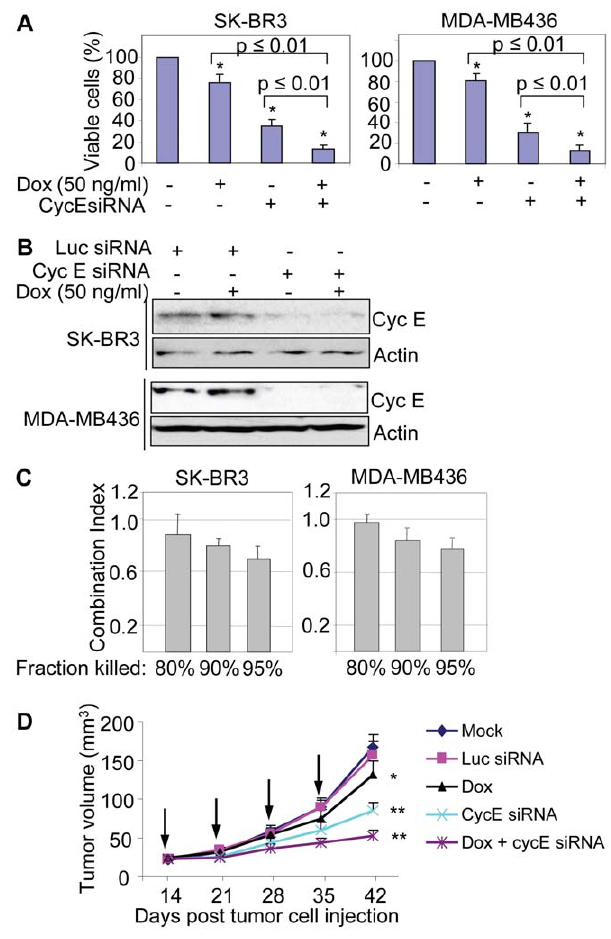
Figure 5. Enhanced inhibitory effects by combination of cyc E siRNA with Dox. A ) Sensitization of breast cancer cells to Dox by treatment of cyc E siRNA. Indicated breast cancer cells (1 6 10 5 /well in 6- well plates) were transfected with cyc E siRNA (0.1 m g/well) for 24 hours. The cells were then split into 96-well plates (2 6 10 3 cells/well) and treated with Dox (50 ng/ml) for 8 days.MTT assay was performed todeterminecell viability. Y-axis represented the relative MTT value from each treatment. (*) p # 0.05 compared with mock. B ) CycE levels are not affected by Dox. CycE-overexpressing breast cancer cells (SK-BR3 and MDA-MB436) were treated without or with siRNA alone, Dox (50 ng/ml) alone or in combination for 48 h. Treated cells were collected and the lysates were subjectedtoWesternblot analysis withanti-cycE andanti-Actinantibodies, respectively. C ) Synergistic cytotoxicityby combination of cyc E siRNA with Dox. SK-BR3 and MDA-MB436 cells were treated with different concen- tration of siRNA (0–0.1 m g/well in six-well plates) and split into 96-well plates. After 8 days incubation with different concentration of Dox (0– 100 ng/ml), cytotoxicity was determined by MTT assay. The CIs were calculated using the CI-isobologram method by Chou-Talalay. CI=1 indicates an additive effect; CI , 1 indicates synergism; CI . 1 indicates antagonism. Data plotted are the CI value at 80, 90 and 95% fraction killed and are means of three independent experiments; bars, SD. D ) CycE siRNA in combination with Dox is able to effectively inhibit the breast tumor growth in mice. MDA-MB436 cells were injected into the mammary glands of the nude mice. Beginning on day 14 post tumor cell injection, the mice were weekly treated with cycE siRNA (10 m g/injection), luciferase siRNA (Luc-siRNA), liposome alone (mock), Dox alone (2 mg/kg body weight via intraperitoneal injection) or cycE siRNA + Dox over 4 weeks as described in Methods section. Arrows indicated thedays whenmice were administered. The effects of treatment on tumor growth were determined by weekly measuring tumor volume. Dox: doxorubicin. (*) p # 0.05 and (**) p # 0.01 compared with mock (M) after 4 administrations.